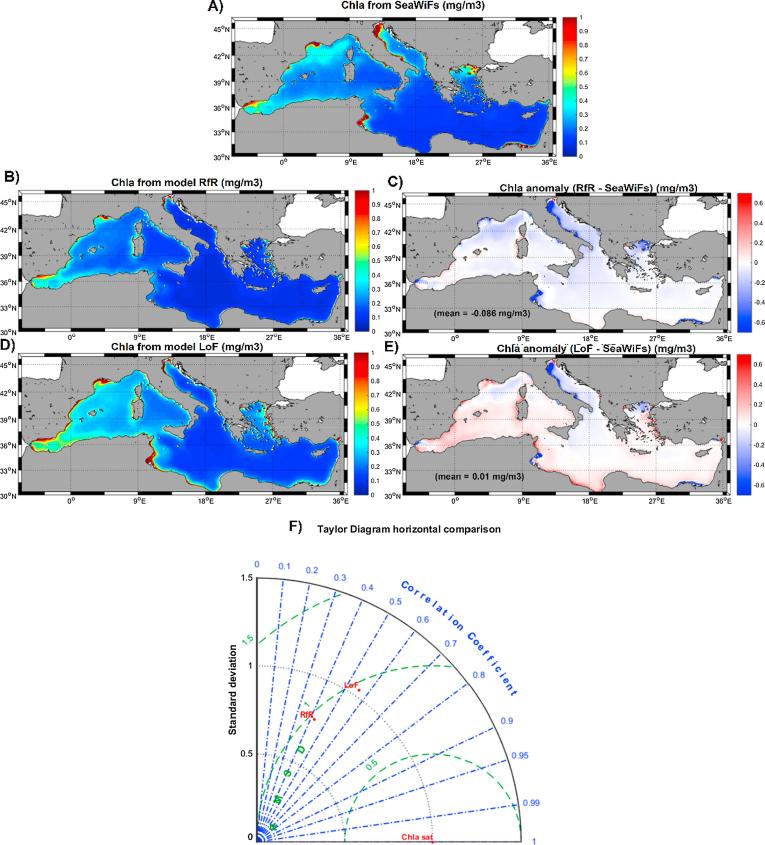
Satellite and model climatological surface chlorophyll for the period 2001–2007. (A) SeaWiFs mean surface chlorophyll concentration (mg/m3). (B) RfR simulation mean surface chlorophyll concentration (mg/m3). (C) Mean RfR – SeaWiFS surface chlorophyll anomaly (mg/m3). (D) LoF simulation mean surface chlorophyll concentration (mg/m3). (E) Mean LoF – SeaWiFS surface chlorophyll anomaly (mg/m3). (F) Taylor Diagram of model-satellite surface chlorophyll comparison.